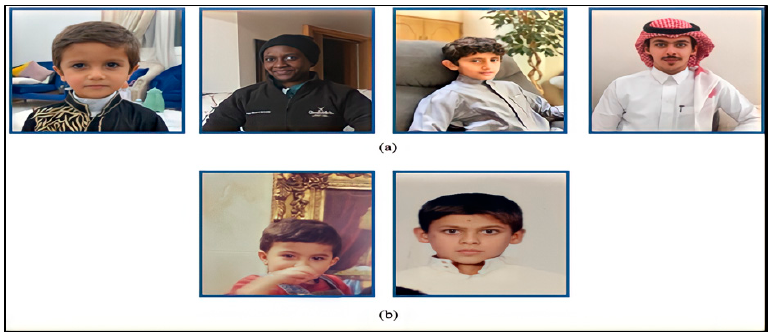
Figure 17. Samples of recognized and not recognized faces: ( a ) represents recognised faces and ( b ) represents unrecognised faces .